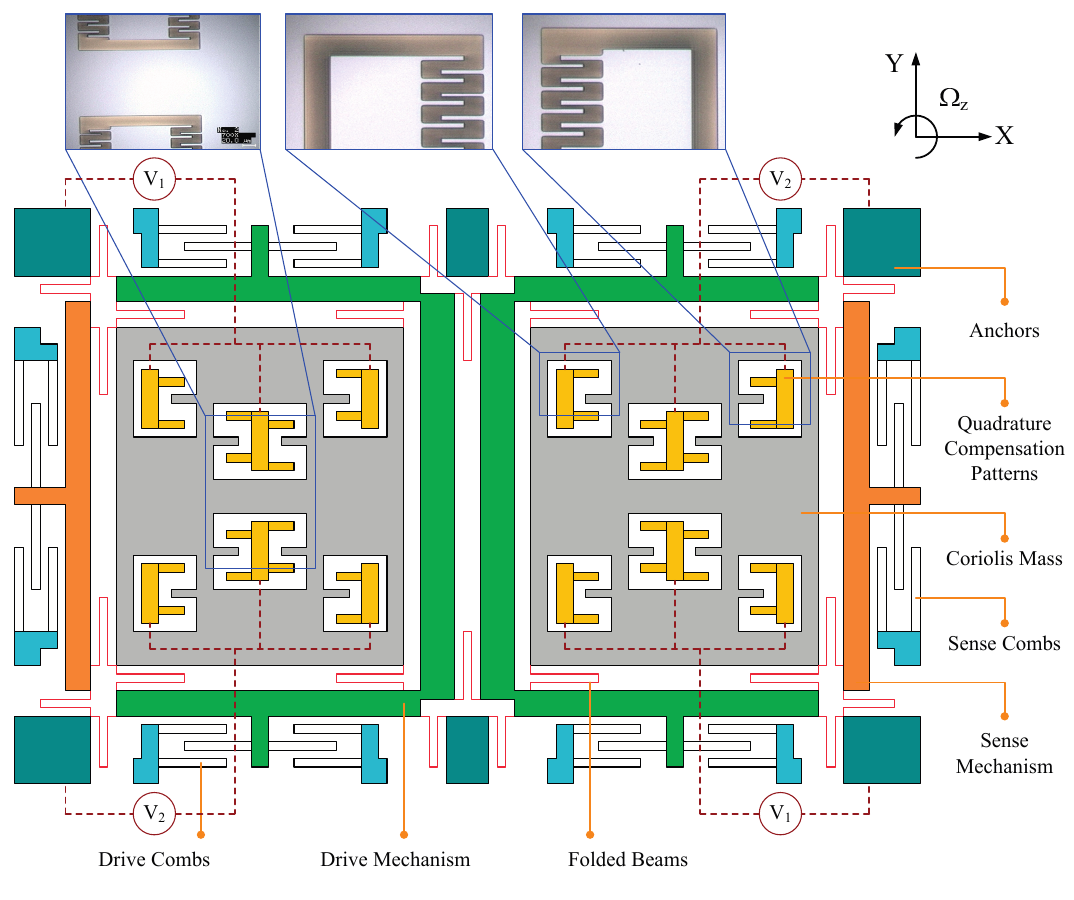
Figure 6. Structural schematic of the dual-mass silicon micro-gyroscope with quadrature compensation patterns.